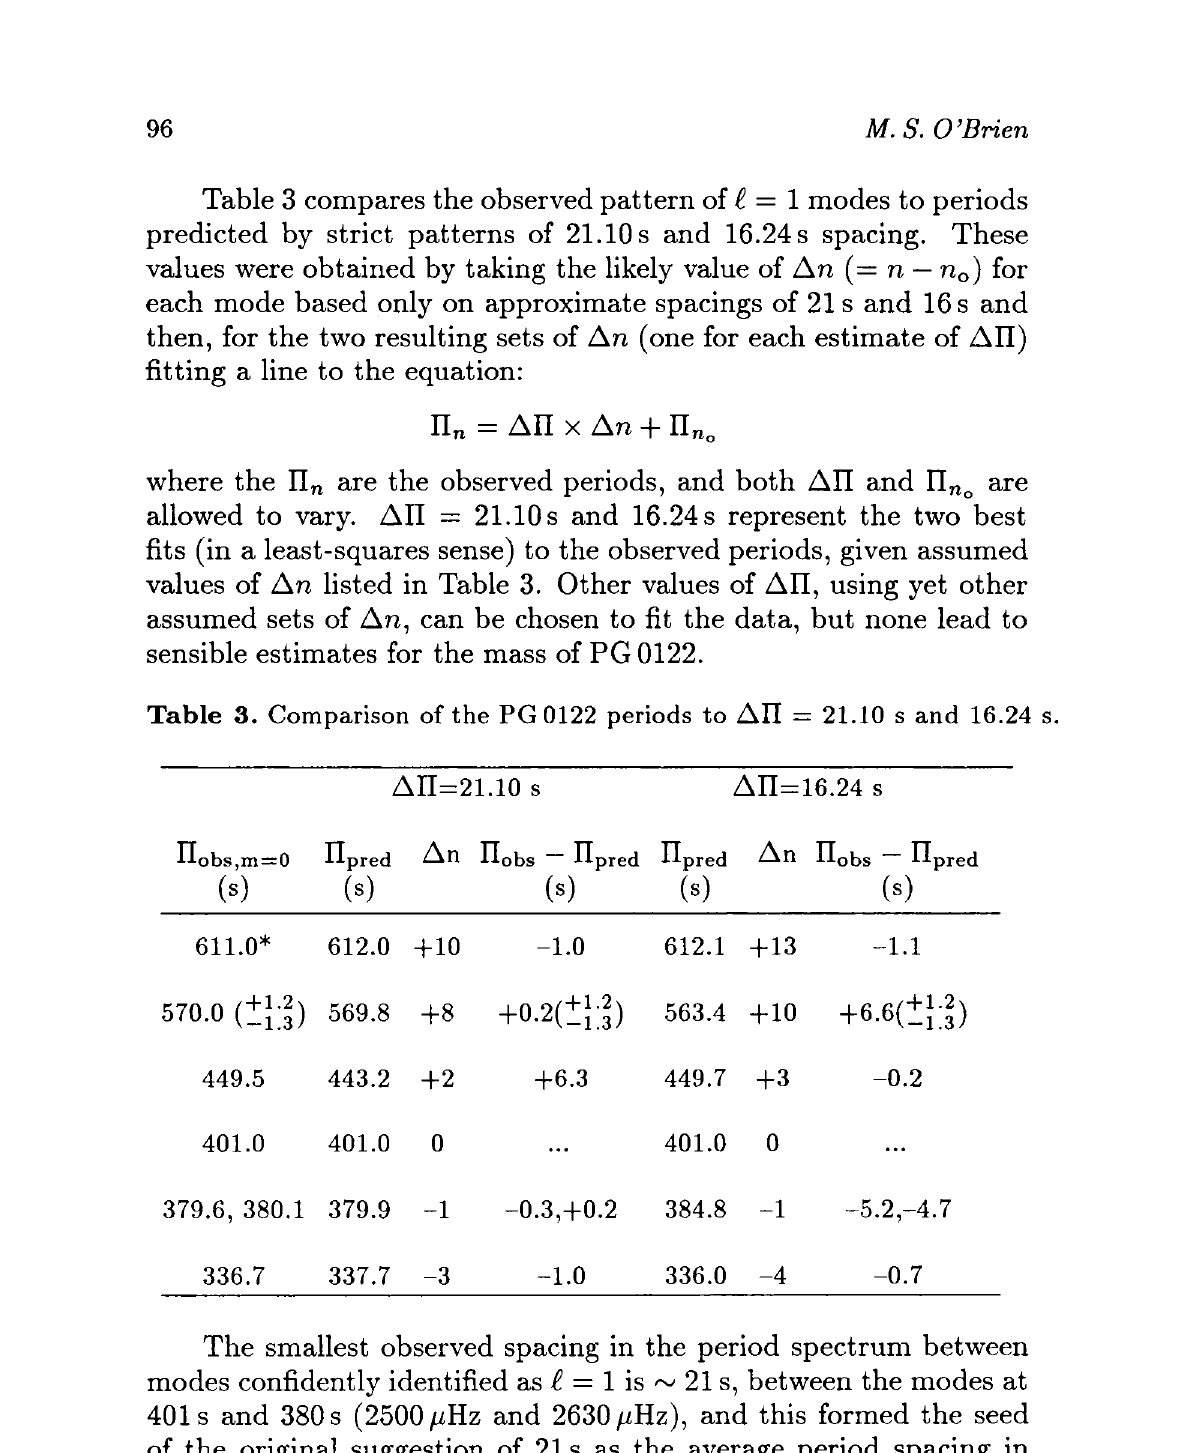
Table 3. Comparison of the PG0122 periods to All = 21.10 s and 16.24